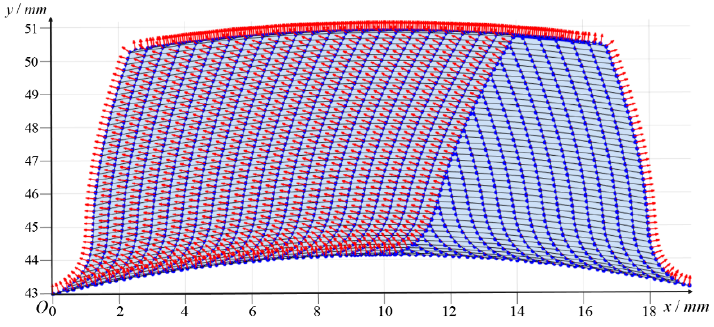
Figure 11. The normal vector model of the actual tooth profile surface.